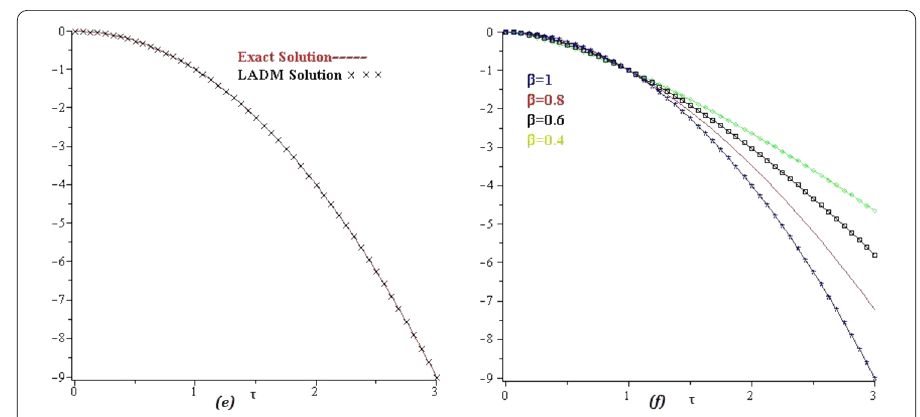
Figure 9 ( e ) Exact and ( f ) LADM solution for Example 3 of w at different values of β